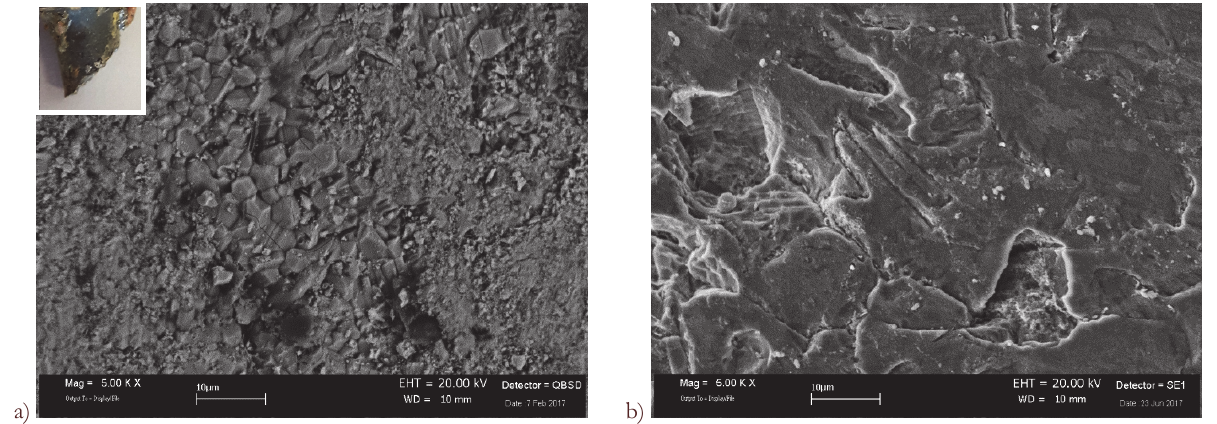
Figure 15: SEM micrographs after Pb creep: fracture surface a) before and b) after chemical